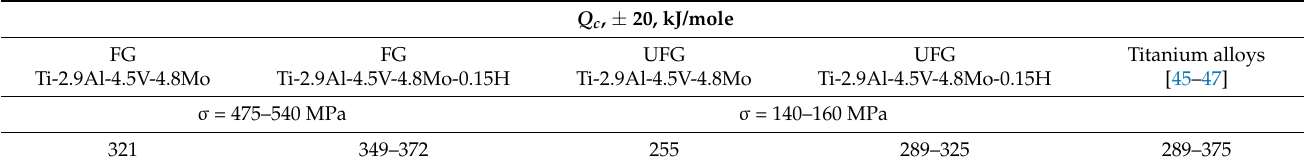
Table 3. The effective creep activation energy for the Ti-2.9Al-4.5V-4.8Mo and Ti-2.9Al-4.5V-4.8Mo-0.15H